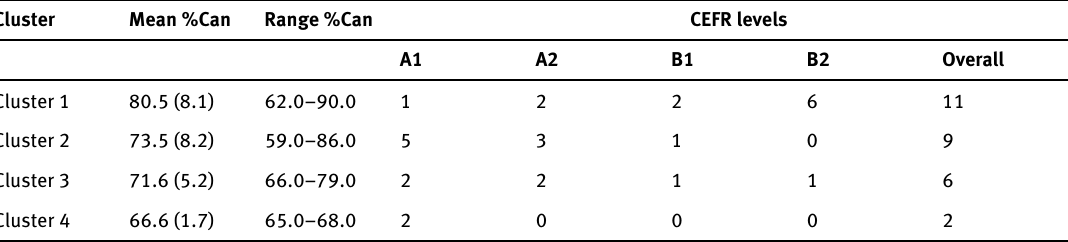
Table 12. Means and standard deviations (SD) for the percentages of canonical classifications per cluster for the acoustic data, including number of Spanish learners per CEFR language proficiency level; %Can = percentages of canonical